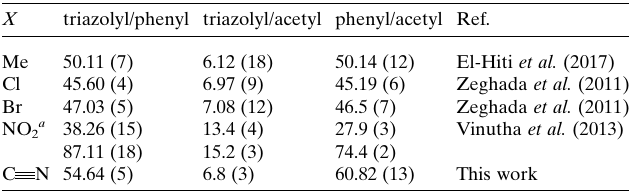
Table 4 Dihedral angle data ( (cid:2) ) for (I) and 4- X -phenyl derivatives.